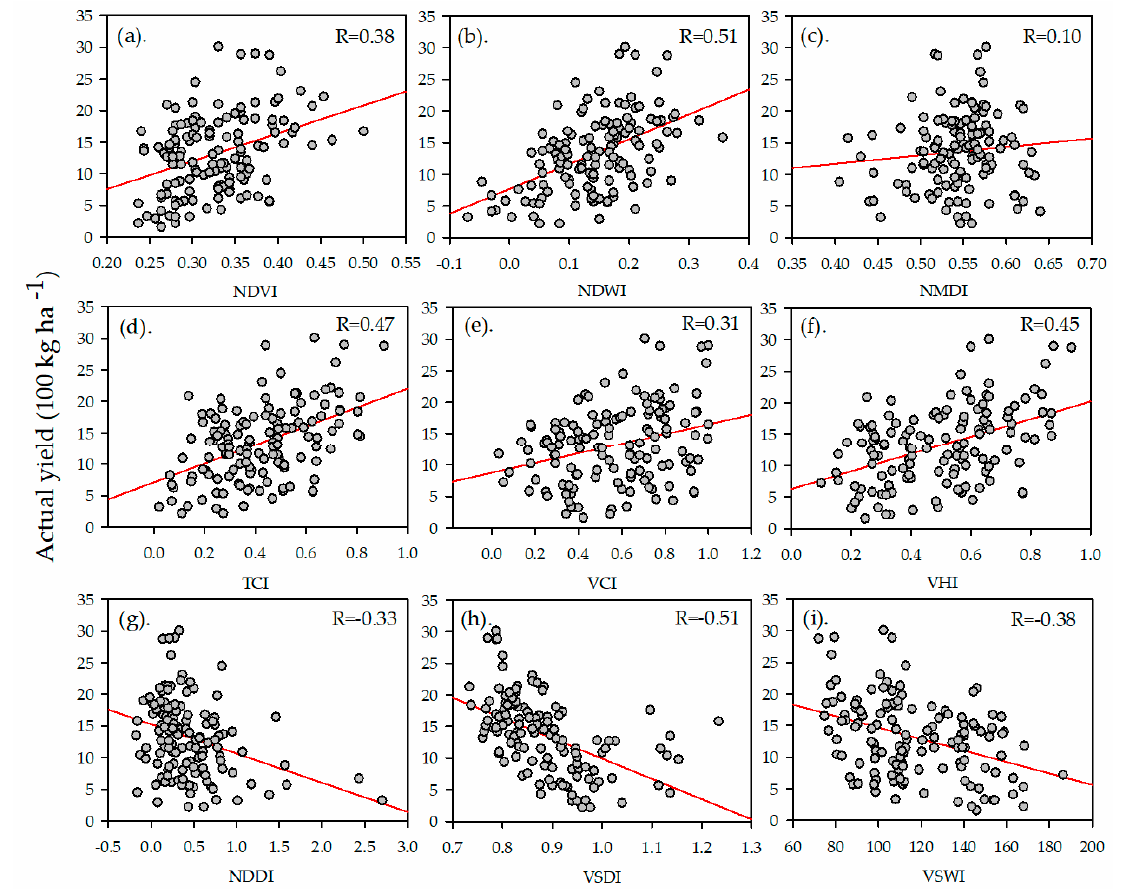
Figure 7. The correlations between spring wheat yield with June ( a ) NDVI, ( b ) NDWI, ( c ) NMDI, ( d ) TCI, ( e ) VCI, ( f ) VHI, ( g ) NDDI, ( h ) VSDI, and ( i )VSWI. Number of samples N = 135.